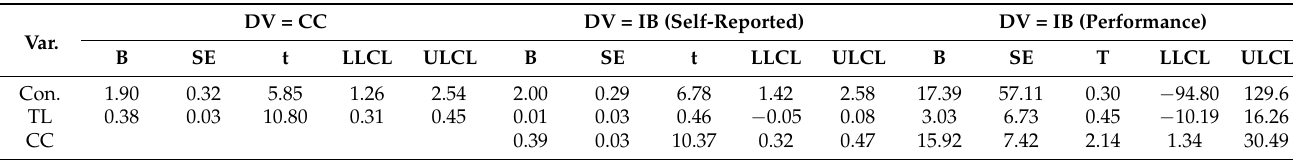
Table 3. Regression analysis for mediation